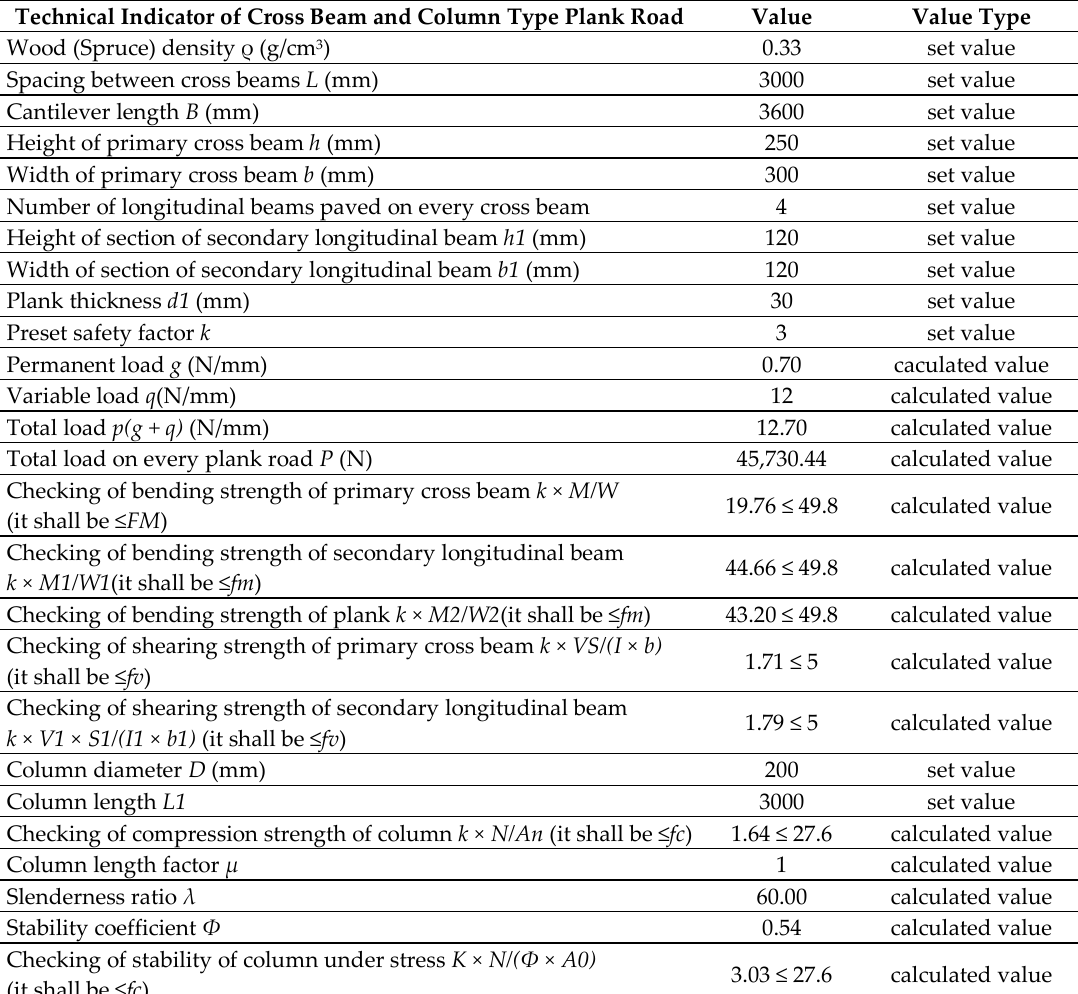
Table 1. Technical indicator and estimation of stress on the cross beam and column type plank. Technical Indicator of Cross Beam and Column Type Plank